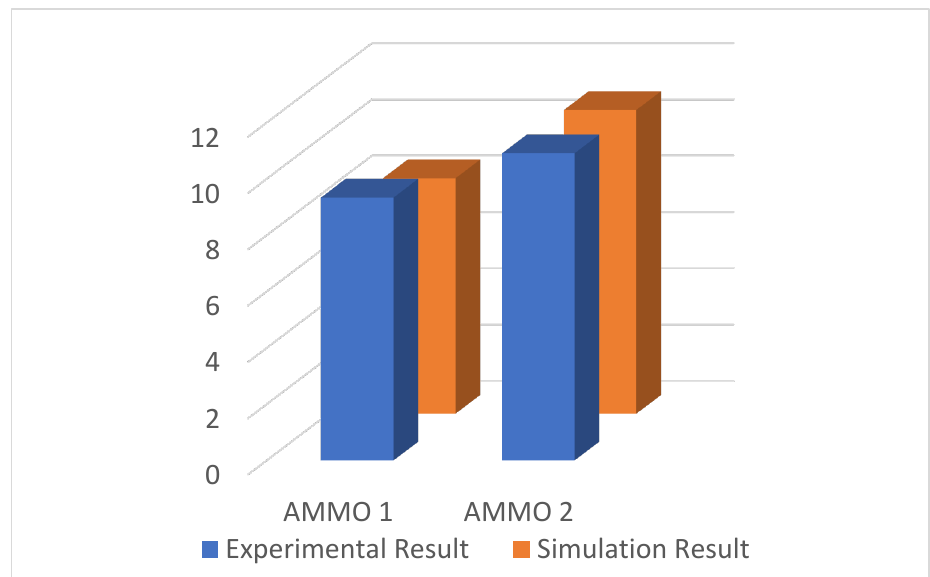
Figure 7. AMMO 2 specific velocity for each time steps graph.